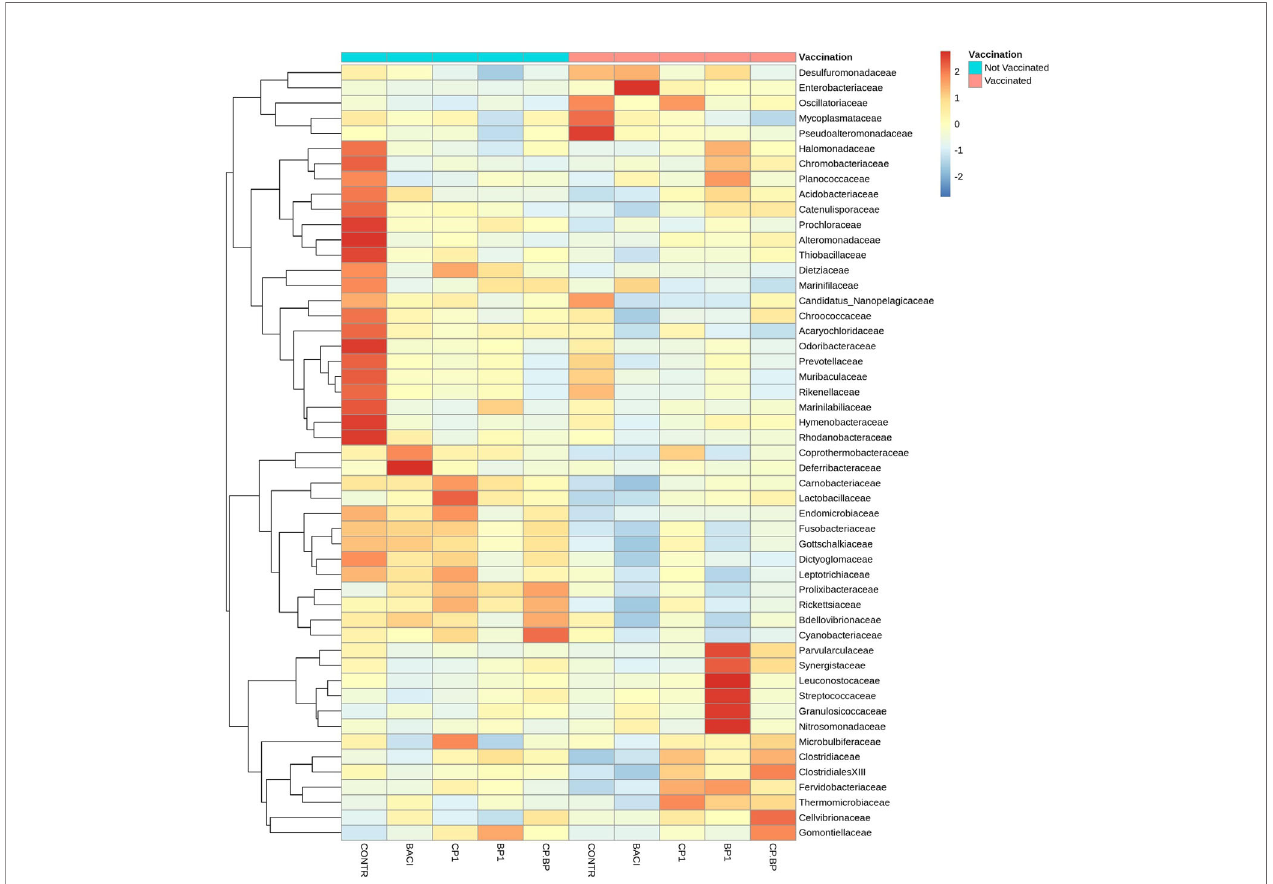
FIGURE 5 | Cecal bacterial communities at the family level in broiler chicken fed bacitracin (55 ppm), 1% of each pomace of cranberry (CP1) and blueberry (BP1) or their combination (CP+BP). Non-vaccinated and vaccinated birds were labeled by blue and red colors, respectively at the top